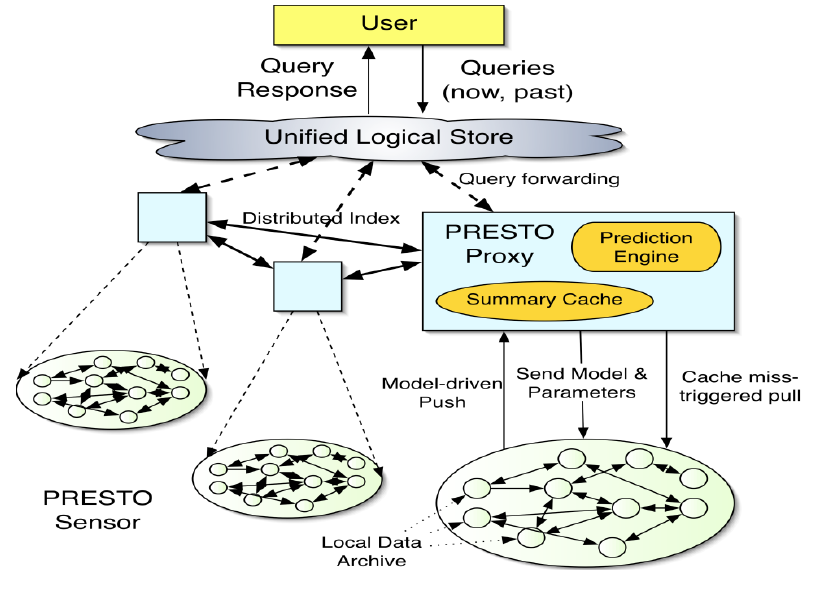
Figure 2. The PRESTO data management